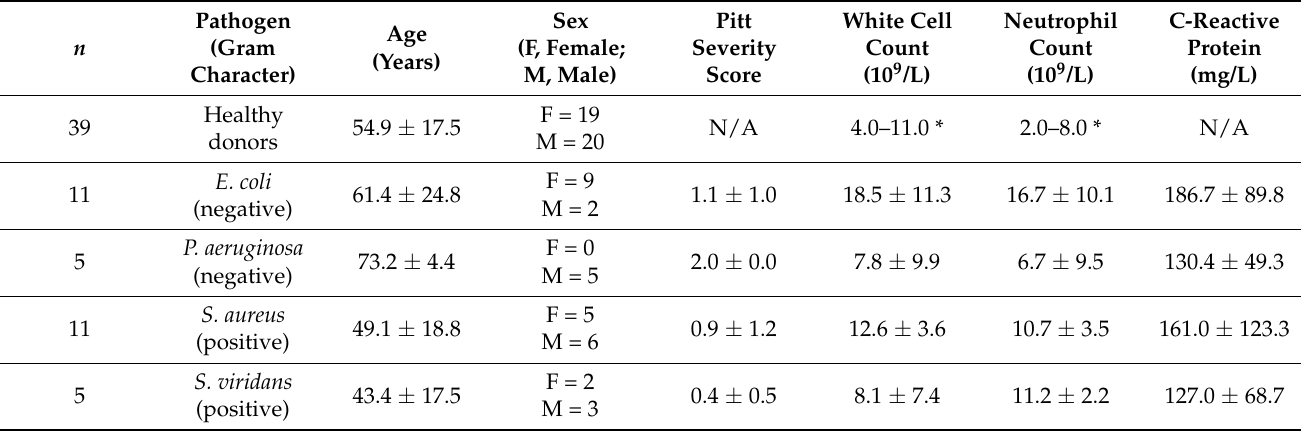
Table 1. Clinical data of the individuals investigated in this study. Data are represented as mean ± SD. N/A, data not available. * Indicates that these values were sourced from published data documenting the normal range of total white cells and neutrophils [55,56] rather than being measured directly from the healthy donors investigated in this study.